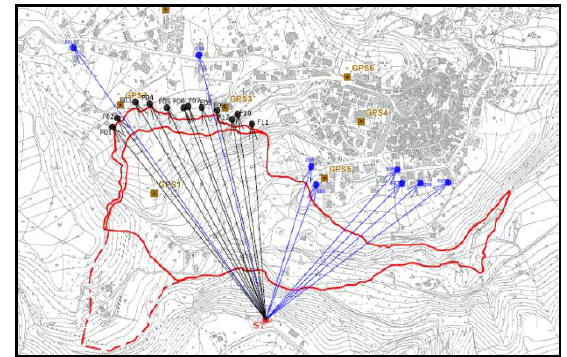
Figure 6.Total Station survey